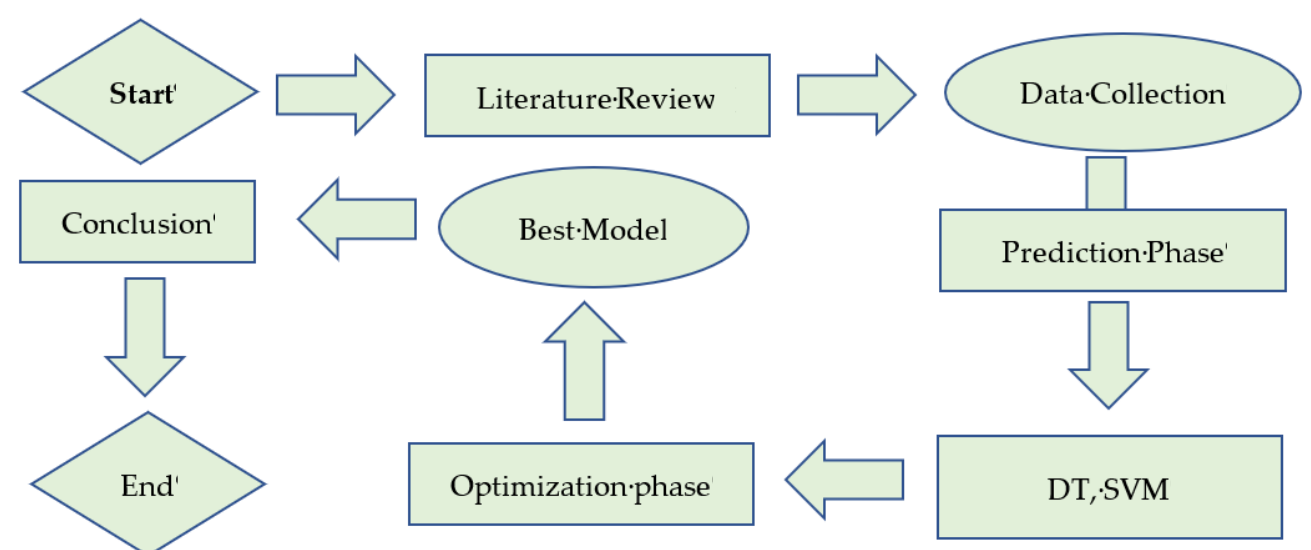
Figure 2. Machine Learning Algorithms.